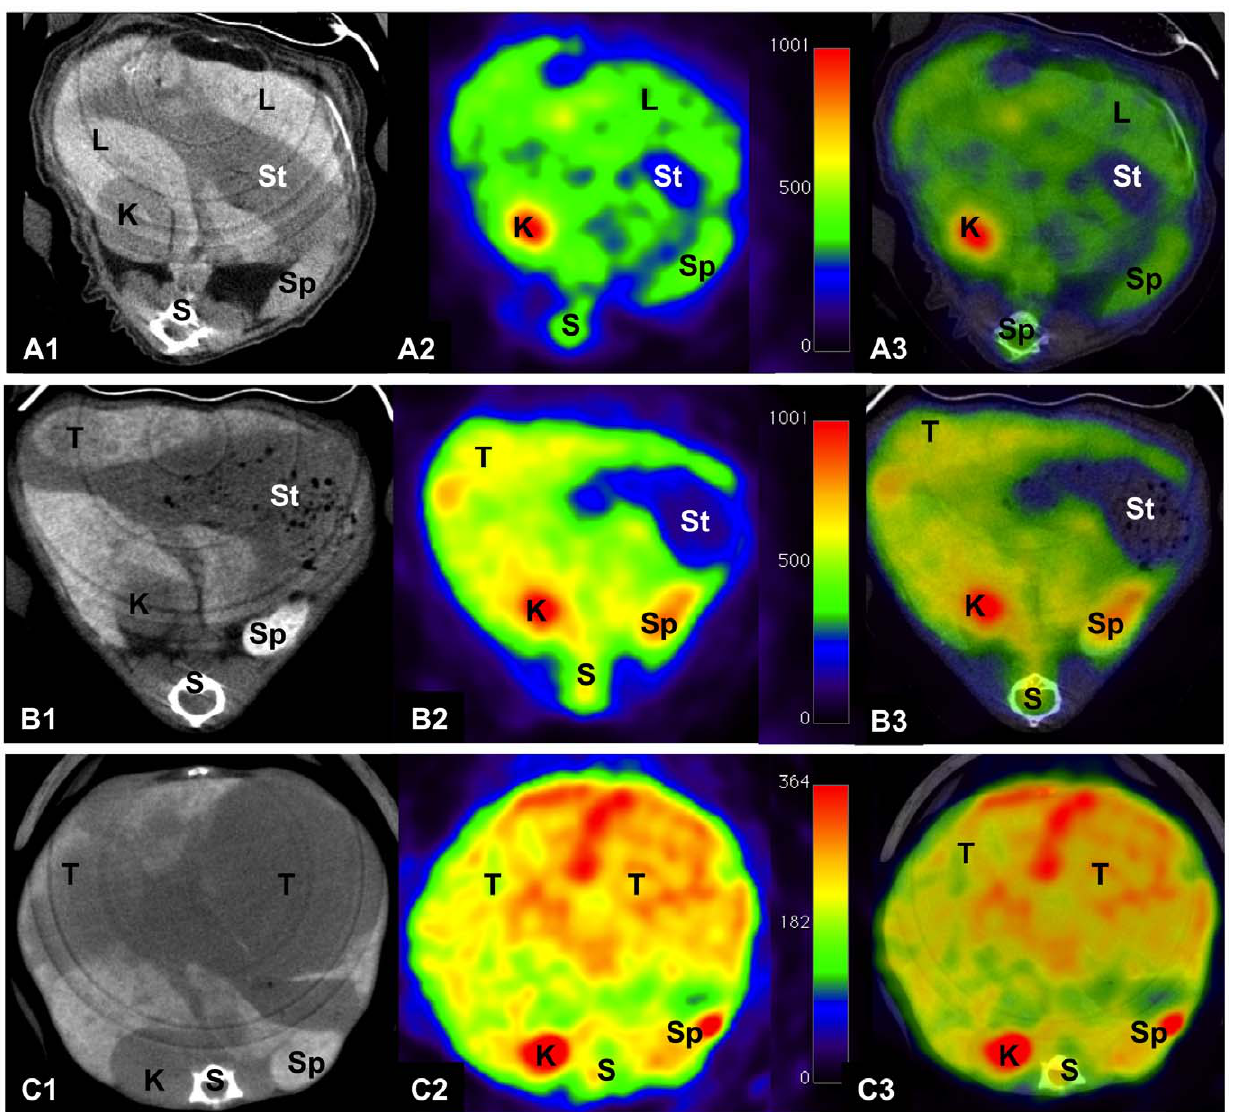
Figure 5. Fused m PET/ m CT images of the liver of c-Myc transgenic mice treated with physiological saline, BHT or NDEA. Depicted are the liver morphology as determined by CT (A1, B1,C1), the glucose metabolism (A2, B2, C2) and fused PET and CT scans (A3, B3, C3) of transgenic animals treated with either physiological saline (A), with BHT (B) or with NDEA (C) at the age of 8.5 months. Note, after treatment with NDEA expansive tumor growth with large increase of liver weight and compression and displacement of adjacent organs was observed. Here, the lesions showed an increased 18F-FDG uptake. In contrast, in corresponding control animals treated with physiological saline no liver lesions were observed. After treatment with BHT small hypodens lesions are noticed, but PET did not show an increased 18F-FDG uptake. K=kidney, L=liver, S=spine, Sp=spleen, St=stomach, T=tumor.